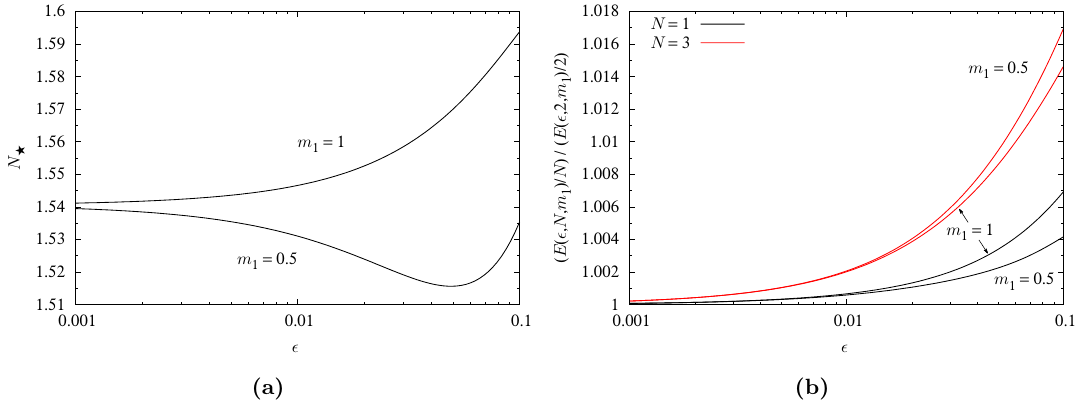
Figure 4. (a) The perturbatively corrected critical value, N ? , of the topological charge N of the axially symmetric baby Skyrmion, as a function of (cid:15) . This critical value formally corresponds to the smallest energy per N . (b) The ratio of the energy of the N -Skyrmion per N and the energy of the 2-Skyrmion divided by 2, for N = 1 , 3 and m = 0 . 5 , 1 , as functions of (cid:15) 1